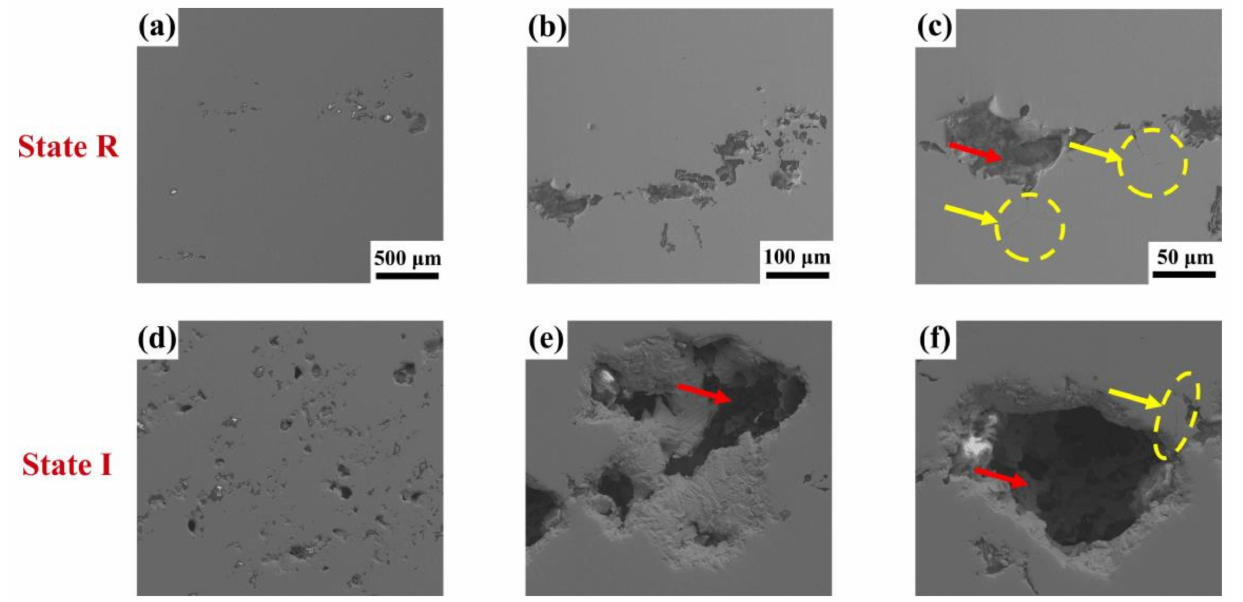
Figure 7. SEM morphologies of the corrosion samples in state R ( a – c ) and state I ( d – f ). A thermal scanning electron microscope (CSLM) was used to observe 3D morphologies of the typical corrosion pits in state R (Figure 8a–c) and state I (Figure 8d–f). It is